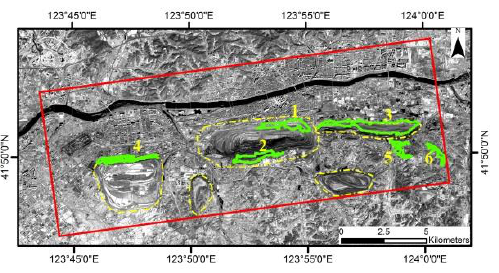
Figure 6 Distribution of deformation areas with declining elevation using ZY-3 DEM in 2015 and ASTER GDEM.